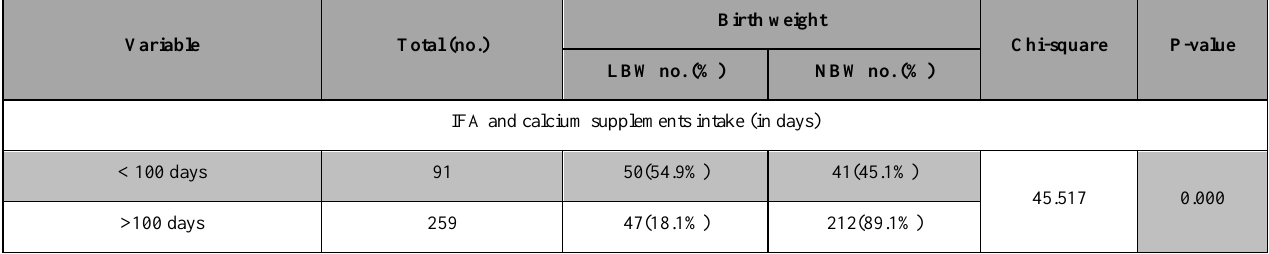
Table 3. Association of low birth weight with IFA and Calcium supplements intake and ANC visits (n=350).